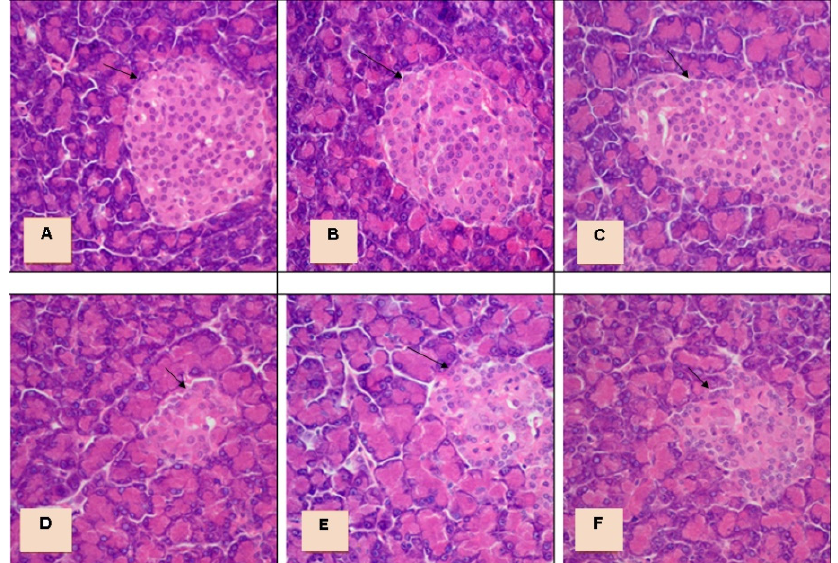
Figure 4. Morphological structure of the pancreas. The arrows show the islets of Langerhans. (( A )—control ( С ), ( B )— С + G (600 mg/kg), ( C )— С + G (1200 mg/kg)—a large number of cells in the pancreatic islets; ( D )—diabetes (D)—small islet of Langerhans with signs of discomplexation of secretory cells with vacuolation of the cytoplasm, ( E )—D + G (600 mg/kg)—dystrophic changes of the islet of Langerhans, ( F )—D + G (1200 mg/kg)—increasing the number of secretory cells, reduced degree of dystrophy). Hematoxylin staining with eosin. Magnification 40 × 10.